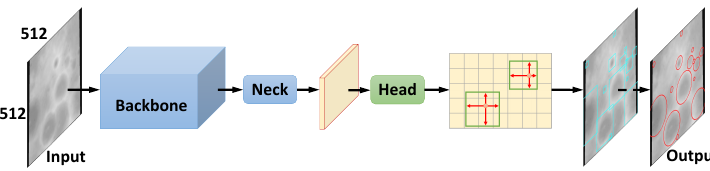
Figure 5. Architecture of the point-based detection network for lunar crater